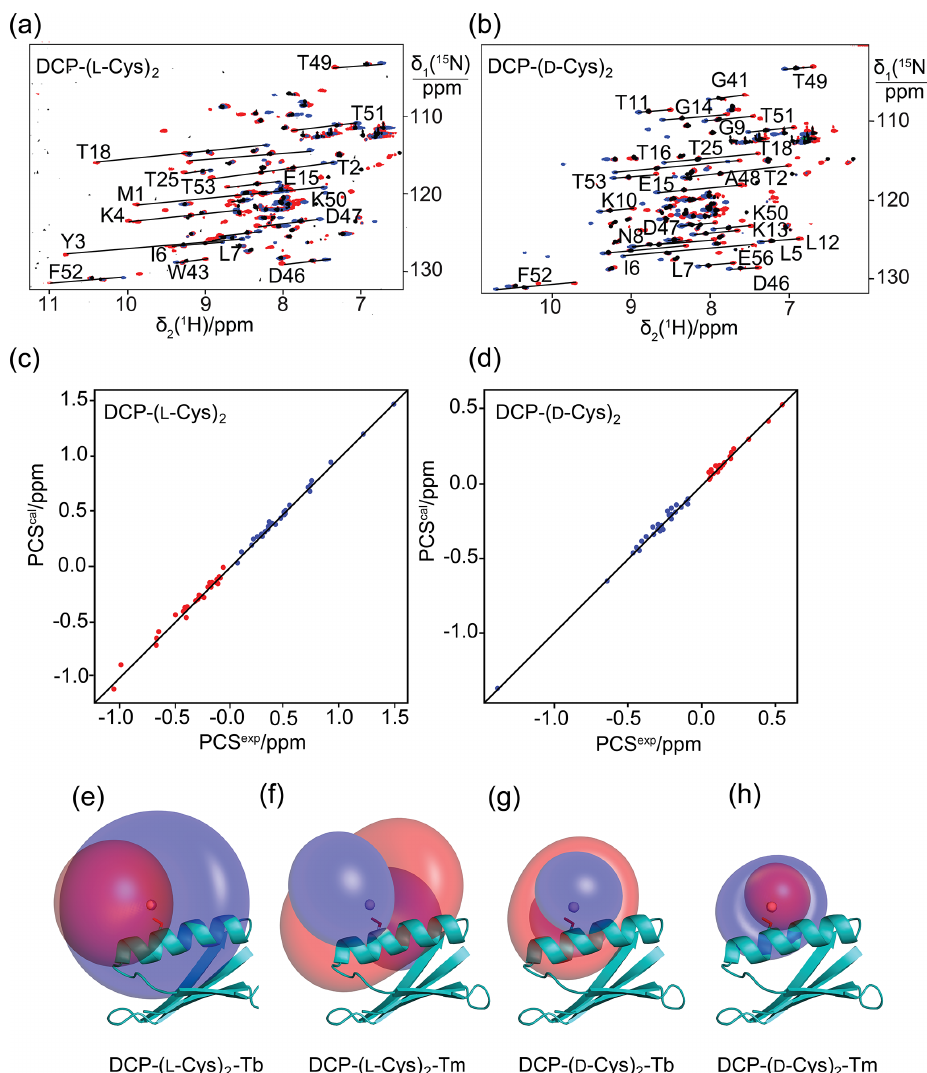
Figure 2. Pseudocontact shifts and (cid:49)χ tensors in the protein GB1 Q32C with DCP-Cys tag. (a) Superimposition of [ 15 N, 1 H]-HSQC spectra of an 0.3mM solution of GB1 Q32C tagged with DCP-( L -Cys) 2 and loaded with either Tb 3 + (red cross peaks), Tm 3 + (blue) or Y 3 + (black). The metal ions were provided in a metal-to-tag ratio of about 0 . 6 : 1. Lines connect corresponding cross-peaks observed with diamagnetic and paramagnetic metal ions. (b) Same as (a) but for GB1 Q32C tagged with DCP-( D -Cys) 2 . (c) Correlation between back-calculated and experimental PCSs of GB1 Q32C tagged with DCP-( L -Cys) 2 . Red and blue points correspond to the PCSs of Tb 3 + and Tm 3 + , respectively. (d) Same as (c) but for the tag assembled with D -Cys. (e) PCS isosurfaces of ± 1ppm determined by the (cid:49)χ tensor of Tb 3 + bound to the DCP-( L -Cys) 2 tag and plotted on a ribbon representation of GB1 Q32C. Positive and negative isosurfaces are shown in blue and red, respectively. The side chain of Cys32 is highlighted with sticks, and the metal position obtained by the (cid:49)χ tensor fit is identified by a ball. (f) Same as (e) but for Tm 3 + . (g) Isosurfaces for the tag constructed with D -Cys and loaded with Tb 3 + . (h) Same as (g) but for Tm 3 +